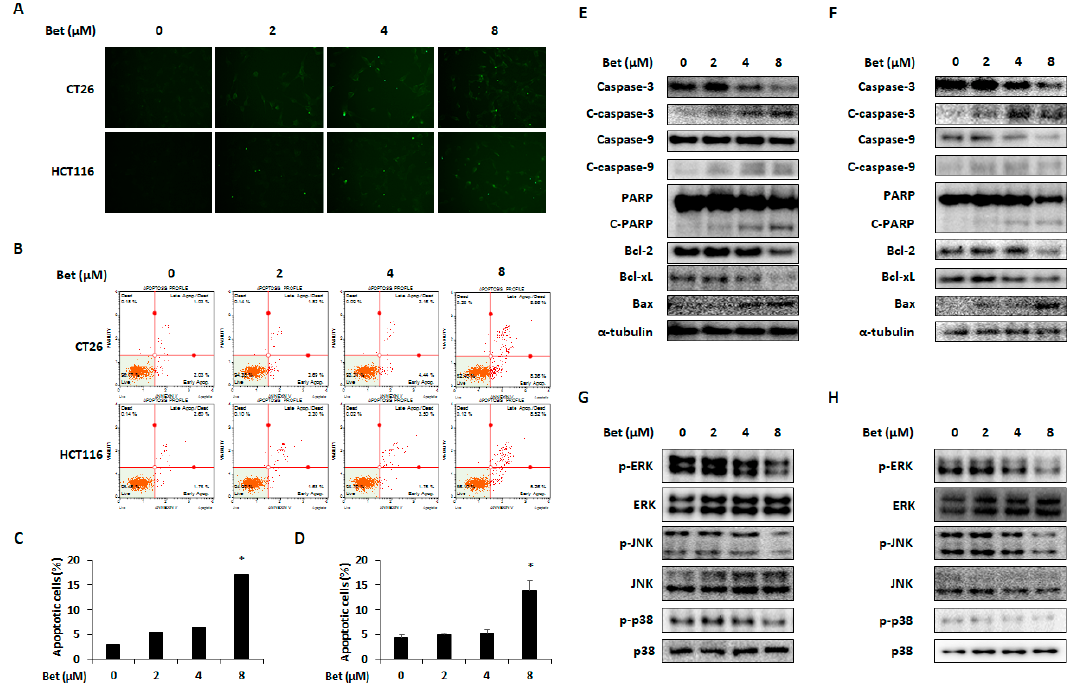
Figure 6. Betulin induces caspase-dependent apoptosis of metastatic colorectal cancer cells via MAPK signaling pathways. Apoptosis of CT26 and HCT116 cells by betulin as detected by TUNEL assay ( A ) and Annexin V assay ( B ). Percentages of apoptotic cells in betulin-treated CT26 ( C ) and HCT116 ( D ) cells. Apoptotic proteins in betulin-treated CT26 ( E ) and HCT116 ( F ) cells. Phosphorylation of ERK, JNK, and p38 in CT26 ( G ) and HCT116 ( H ) cells with betulin treatment. Images represent three independent experiments. Data are means ± standard deviation of three independent experiments. * p < 0.05.